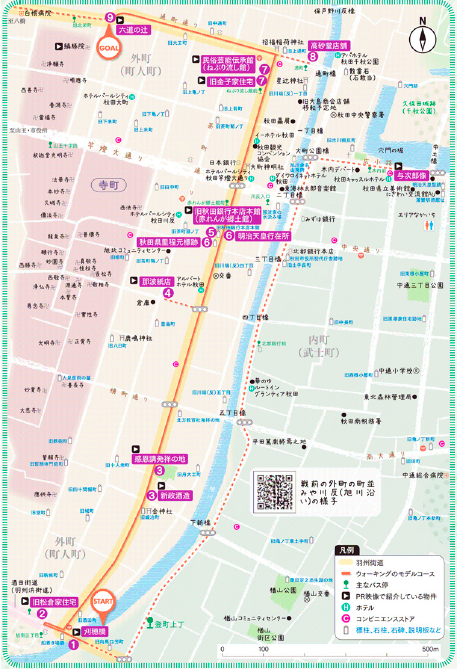
Figure 11. Illustrated map that examinees used in this experiment (Tomachi Area (traditional downtown area), Akita City, Japan).